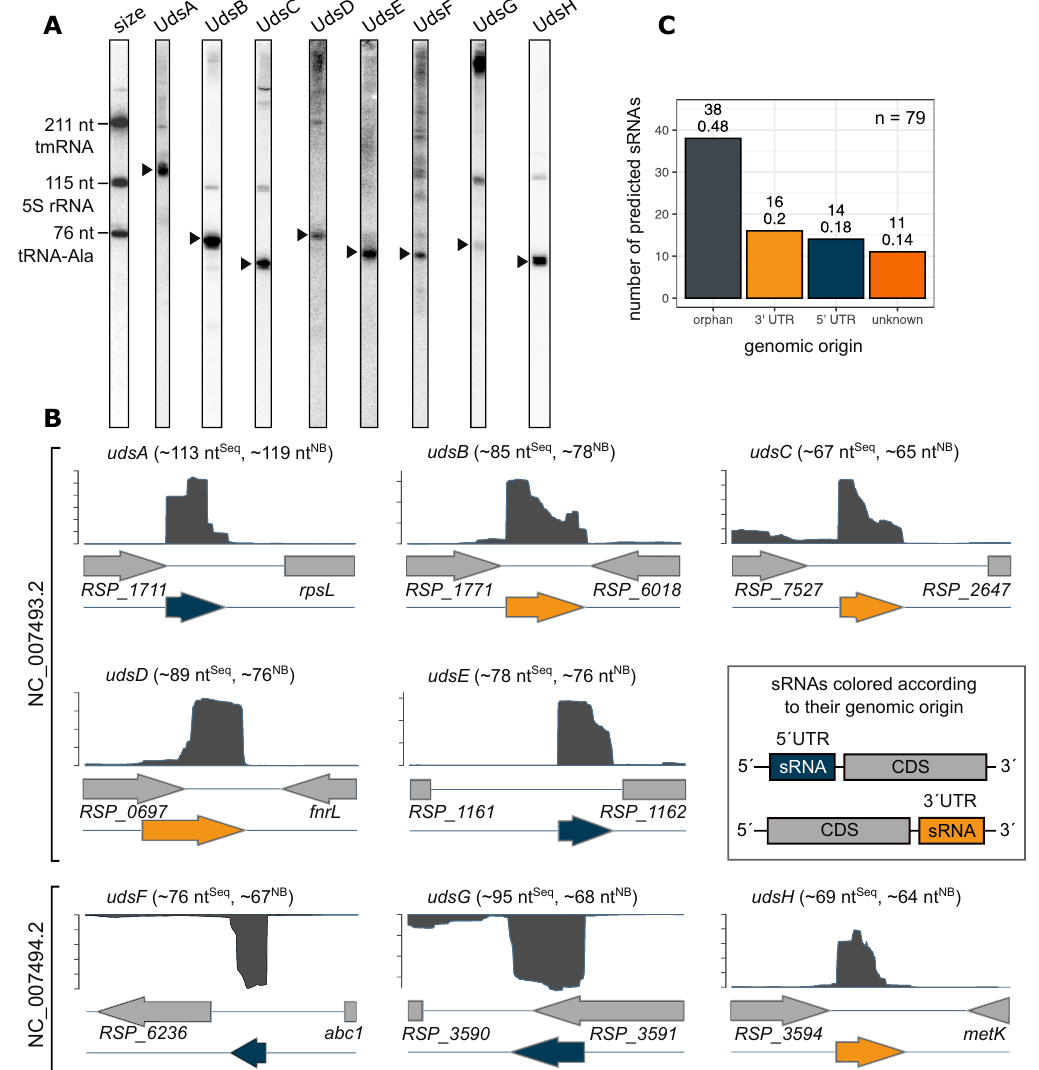
Figure 1. Identification of novel UTR-derived sRNAs in Rhodobacter sphaeroides . ( A ) 10 µg of total RNA from exponentially growing R. sphaeroides wild type cultures were separated on a denaturating 10% PAA gel and subsequentially blotted. Probes were directed against predicted sRNA sequences. Black triangle marks the mature sRNA. The tmRNA (211 nt), 5S rRNA (115 nt) and tRNA-Ala (76 nt) were used as an internal size standard. 5S rRNA served as loading control. Three sRNAs have previously been mentioned: UdsA (formerly IGR_RSP_1711_rpsL; [37]), UdsC (formerly the sRNA downstream of RSP_7527 ; [16]), and UdsE (formerly RSs2778; [46]). ( B ) Total read coverage of the Uds’ loci. Axis’ not to scale. Lengths were predicted by RNA sequencing ( Seq ) and northern blot analysis ( NB ). ( C ) The genomic origin of all known and predicted sRNAs in R. sphaeroides was prediced. Nearly 50% of all sRNAs originate from orphan genes. total n =